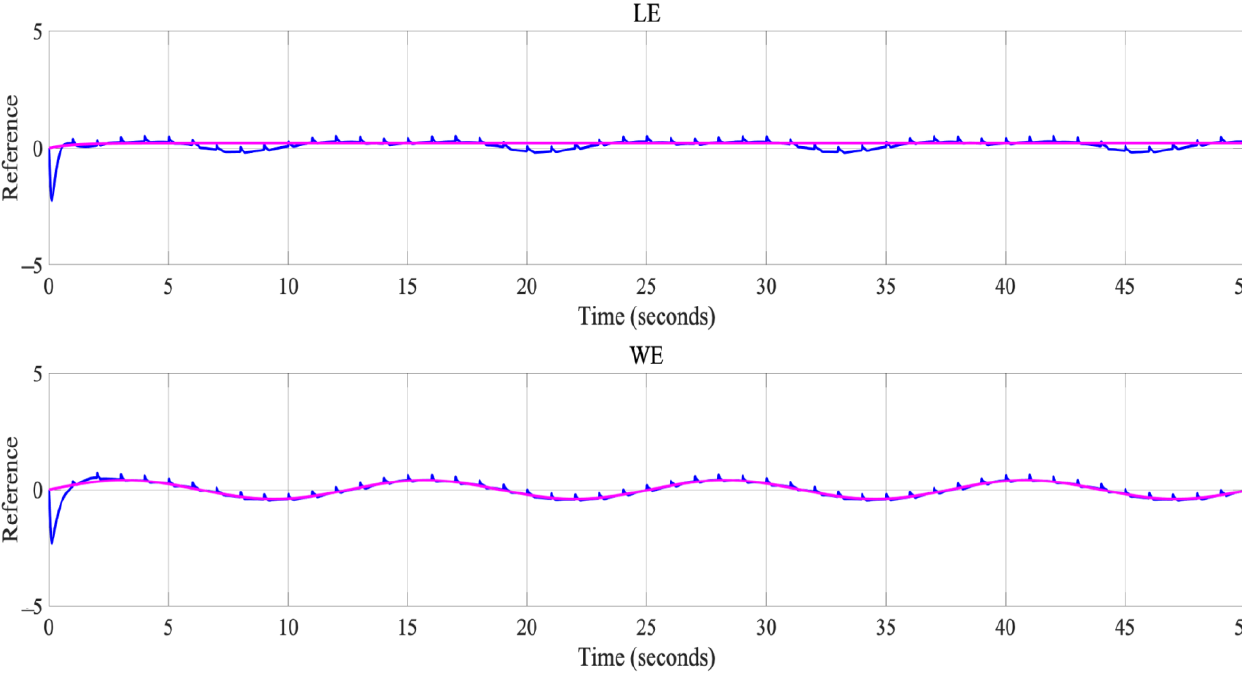
Figure 12. Representation of the best result representing the LE and the WE.